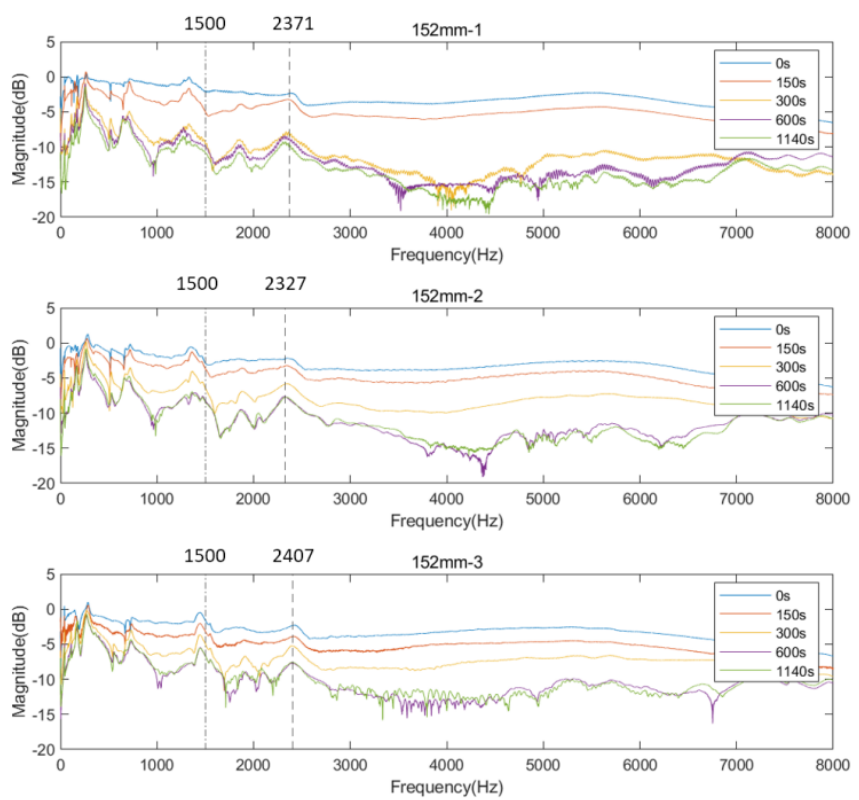
Figure 7. Cross-spectrum of normalised magnitude for the residual length of 152 mm at 0, 150, 300, 600, and 1140 s cure times.